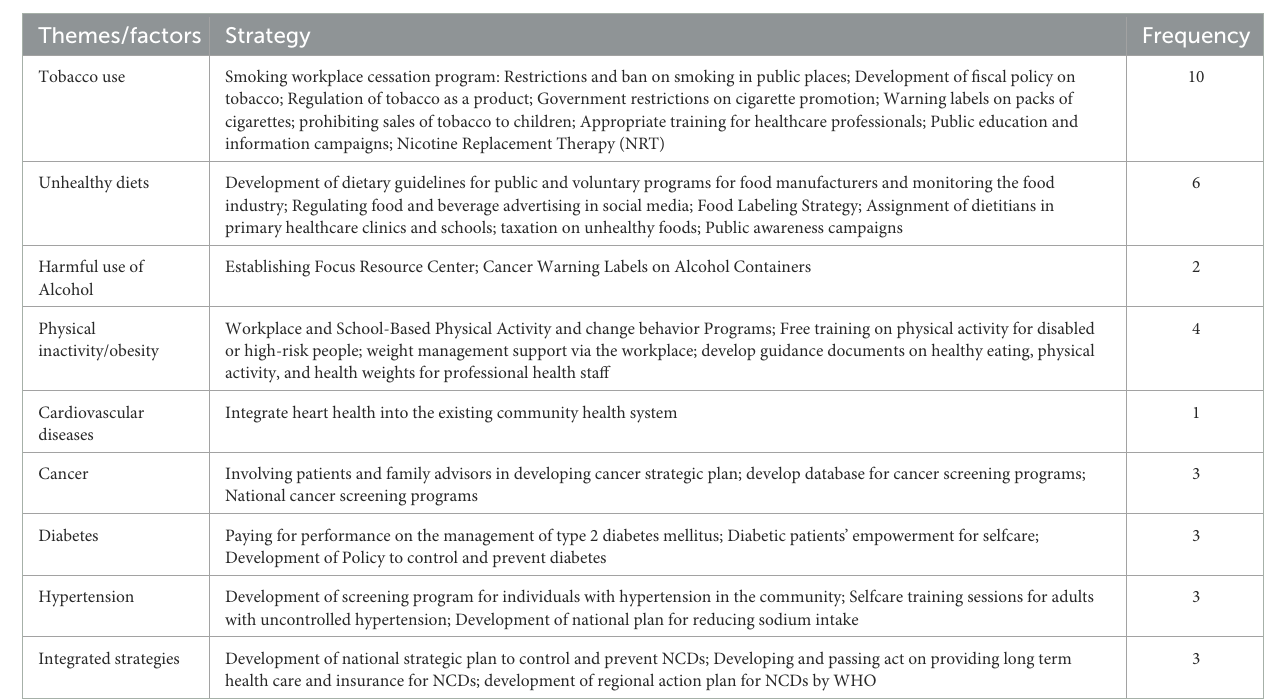
TABLE 2 Population-based strategies for the prevention and control of NCDs. Themes/factors